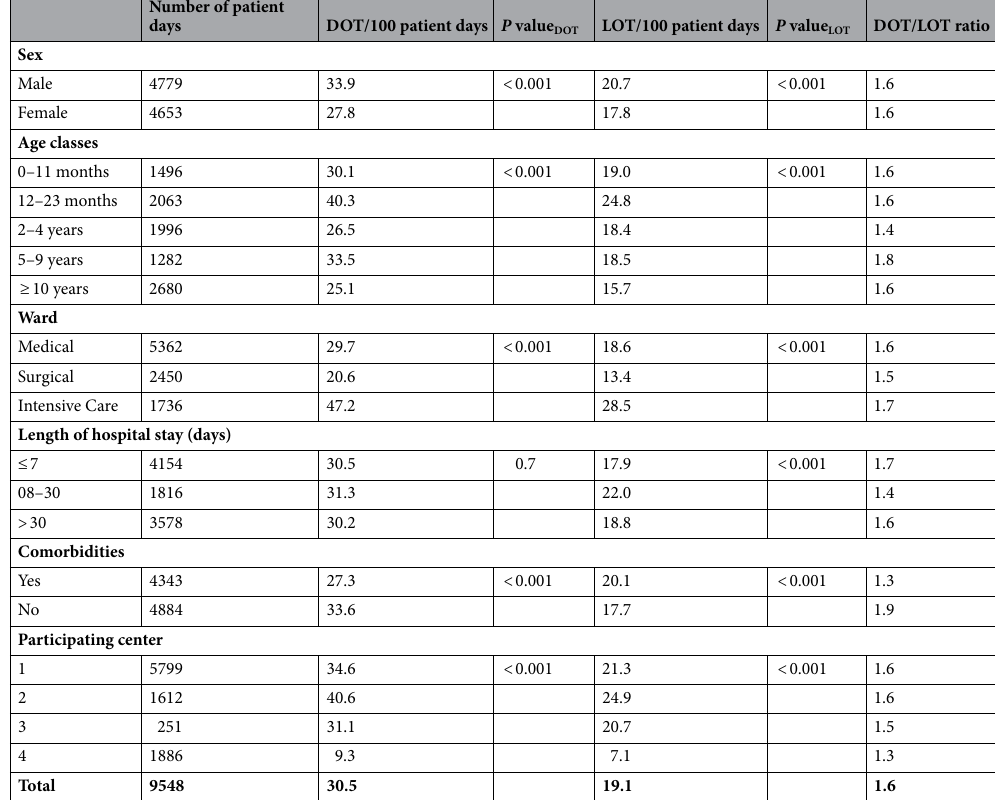
Table 2. Patient days, DOT–LOT per 100 patient days and DOT/LOT ratio calculated for antibiotics provided for therapeutic purposes by sex, age classes, hospital ward, lenght of hospital stay, comorbidities and participating